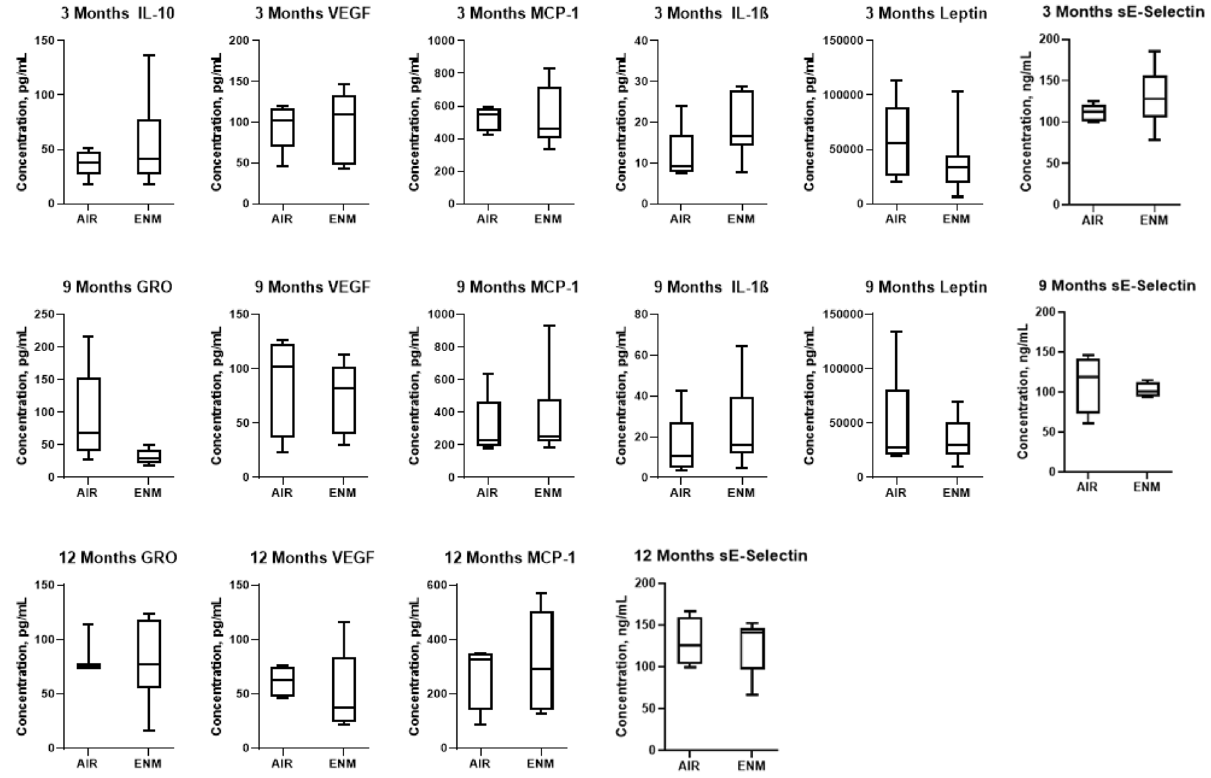
Figure 7. Inflammation and Vascular Injury panel. Plasma IL-10, IL1-β, Leptin, MCP-1, VEGF, GRO, and sE-Selectin were assessed between Sham-Control or ENM offspring at 3, 9, and 12 months of age. IL-10, interleukin 10; IL-1β, interleukin 1 beta; MCP-1, monocyte chemoattractant protein-1; VEGF, Vascular endothelial growth factor. Values are shown as mean ±